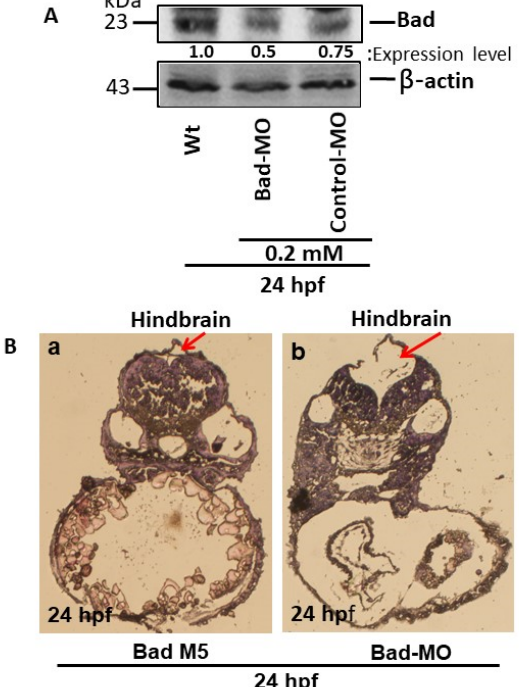
Figure 1. The BH3 ‐ only proapoptotic gene Bad can regulate brain development at 24 hpf. ( A ) Bad knockdown (lane 2 for 0.2 mM) shown by Western blot analysis and compared to the uninjected group (lane 1) and the normal control Bad ‐ M5 group (lane 3). The protein expression levels were quantified by a Personal Densitometer (Molecular Dynamics). ( B ) Dis ‐ section and observation of brain development in loss ‐ of ‐ Bad ‐ mediated PCD embryos at 24 hpf. HE staining showing hind ‐ brain development in the Bad ‐ M5 group in panel ( Ba ) and the Bad ‐ Mo group in panel ( Bb ) at 24 hpf, as indicated by red arrows. indicated by red